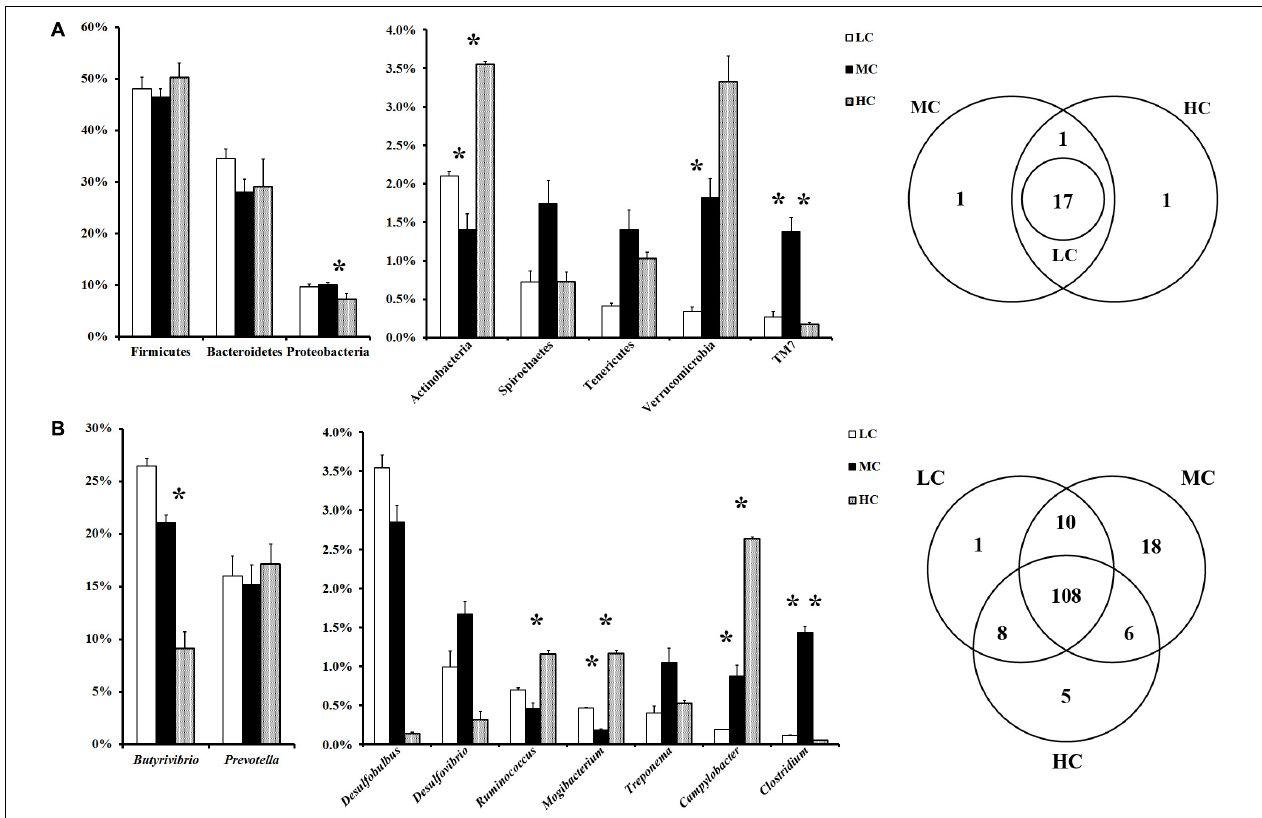
FIGURE 1 | (A) Phylum-level comparison of bacterial OTUs across groups; (B) genus-level comparison of bacterial OTUs across the groups. MC group was used as the control for the comparison; “ ∗ ” located between first two columns indicates a p < 0.05 in the t -test of MC and LC groups; “ ∗ ” located between next two columns indicates a p < 0.05 in the t -test of MC and HC